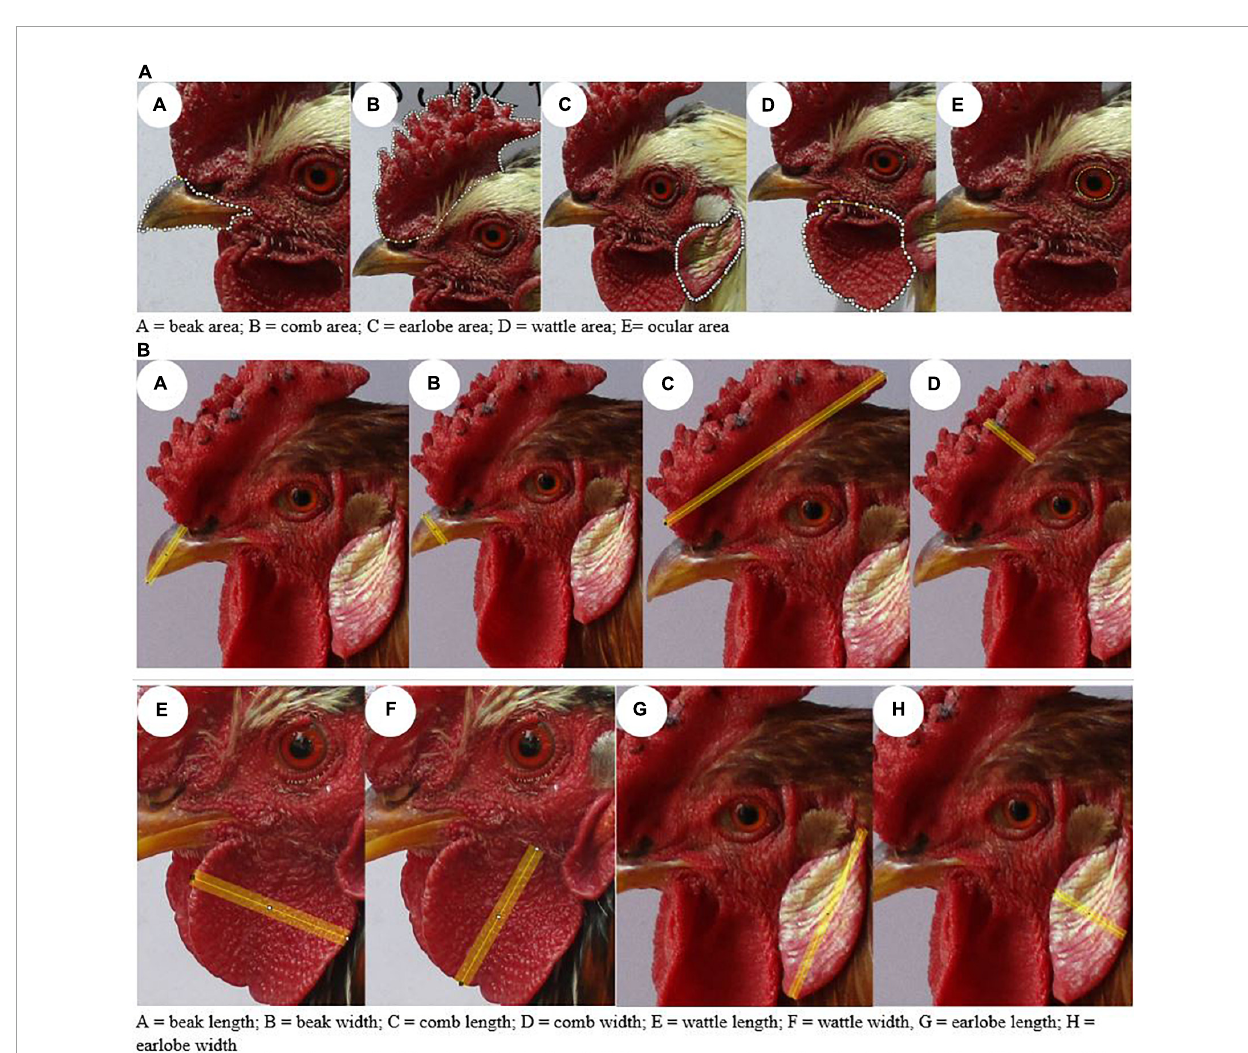
FIGURE2 Example of photographs of morphological traits and their measurements for their analysis using the ImageJ software. (A) Surface area. (B)